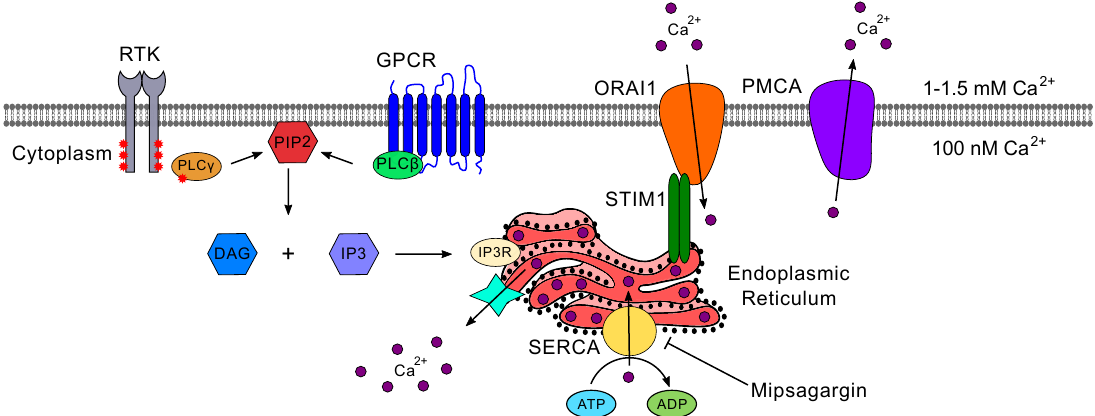
Figure 6. G-protein-coupled receptor (GPCR) and RTK regulation of phospholipase C (PLC) and calcium signaling. GPCRs activate PLC β while RTKs phosphorylate and activate PLC γ , and these subunits work together to cleave phosphatidyli- nositol 4,5-bisphosphate (PIP2), found in the cell membrane, into diacylglycerol (DAG) and inositol 1,4,5-trisphospate (IP3). IP3 receptors (IP3R) line the endoplasmic reticulum (ER) membrane, and IP3 binding opens calcium ion (Ca 2+ ) channels to allow Ca 2+ to flow into the cytoplasm. Sarcoendoplasmic reticular Ca 2+ ATPase (SERCA) transporters maintain stored calcium in the ER. When ER calcium is depleted, stromal interaction molecule (STIM) proteins form multimers that translocate to ER–plasma membrane junctions and recruit Orai channels to initiate calcium entry into the cell. Subsequently, homeostasis is maintained by plasma membrane Ca 2+ ATPase (PMCA), which transfers Ca 2+ from the cytosol out of the cell to maintain its gradient against the extracellular environment (~100 nM vs. ~1–1.5 mM,